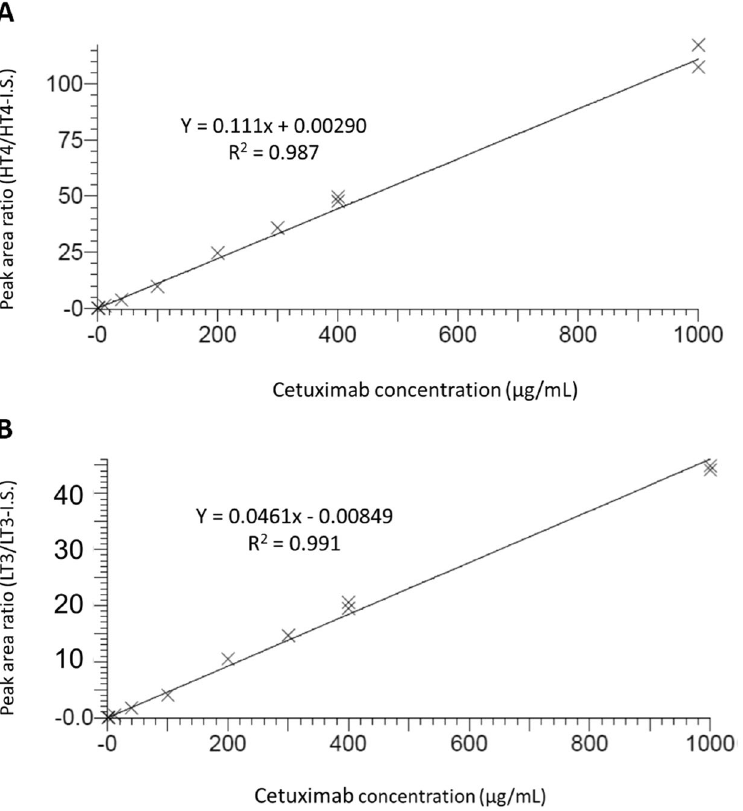
Figure 3. Linearity of Cetuximab quantification in human plasma. Results for HT4 ( A ) and LT3 ( B ) peptides are illustrated. Cetuximab was diluted in blank human plasma from 1 to 1000 µ g/mL. Equation of the curve and correlation coefficient are indicated on the graphs.